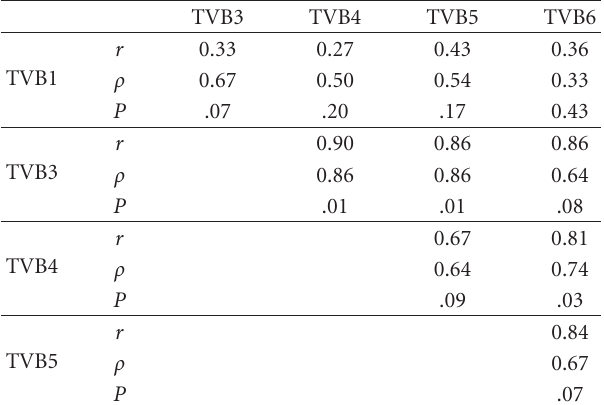
Table 3: Correlation among questions of the post-task question- naire ( r denotes Pearson’s product-moment correlation coe ffi cient, ρ denotes Spearman’s rank correlation coe ffi cient and P the associated P -value). The questions TVB1 through TVB6 are listed in Table 1.